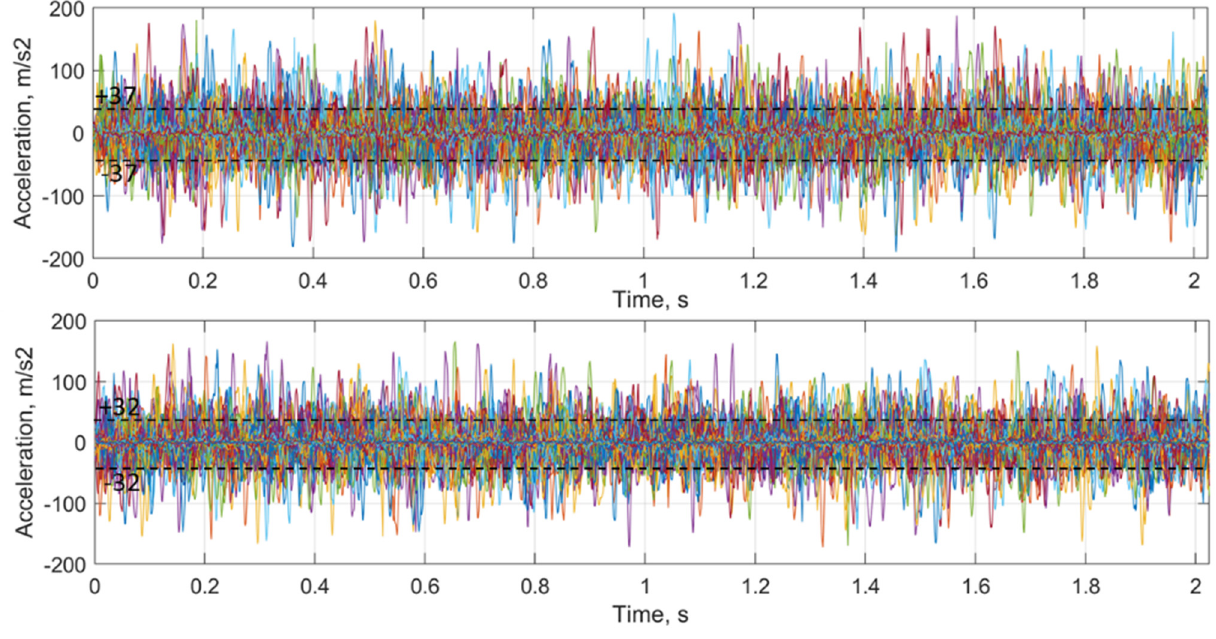
Figure 18. The raw time series of rail acceleration in void ( top ) and reference zone ( bottom ).